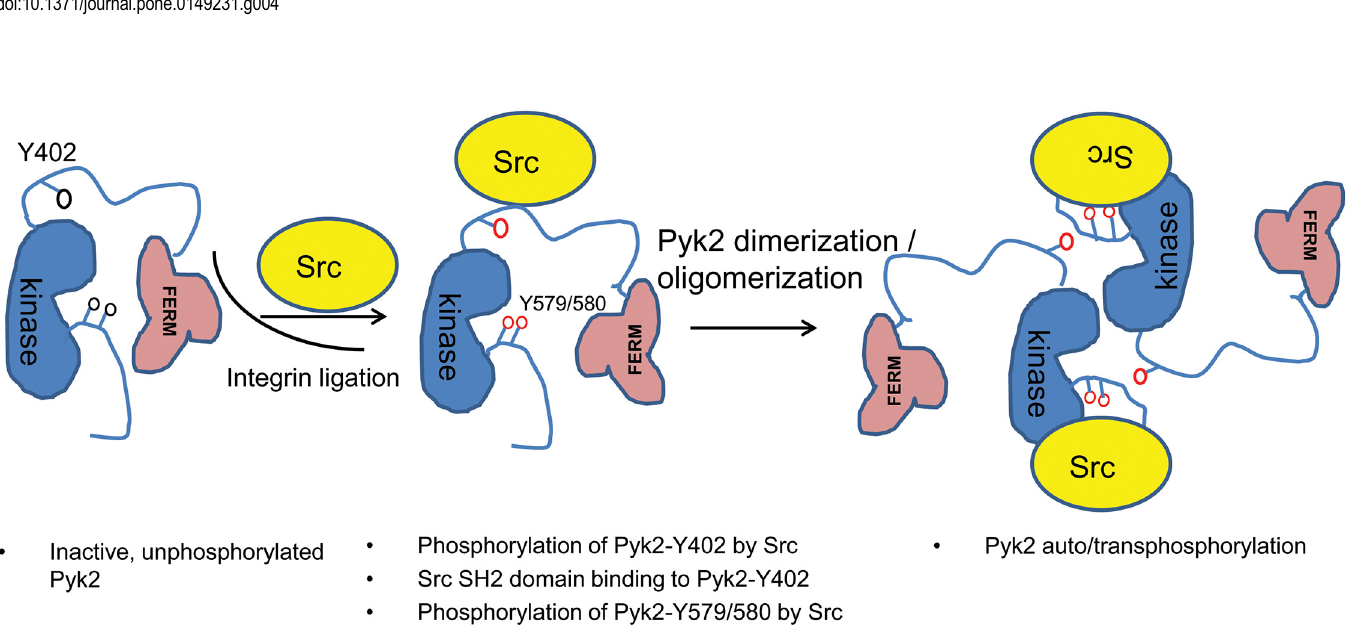
Fig 5. Schematic representation of Pyk2 phosphorylation triggered by Src. In the inactive state, Pyk2 is in an unphosphorylated state. Upon integrin ligand binding, Src phosphorylates Y402, creating a binding site for the SH2-domain of Src, and enabling further phosphorylation of Pyk2 by Src, including at site Y579 (and likely at Y580, although not studied here). As shown by others [21,22] phosphorylated and activated Pyk2 dimerizes or oligomerizes with itself, leading to further phosphorylation of Pyk2 via auto/trans-phosphorylation.